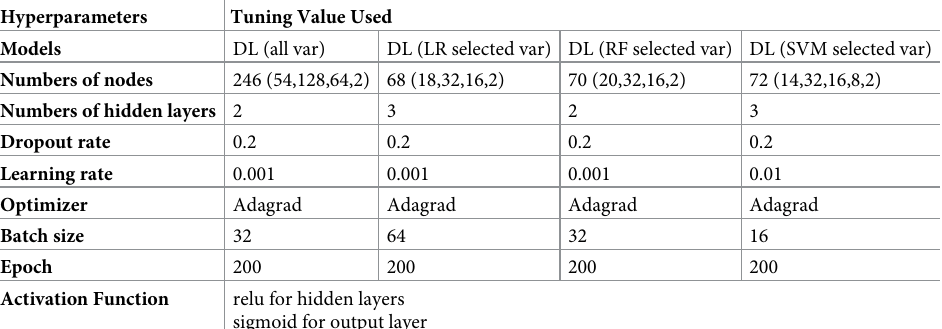
Table 3. Hyperparameters used for all the DL models with all and selected features.